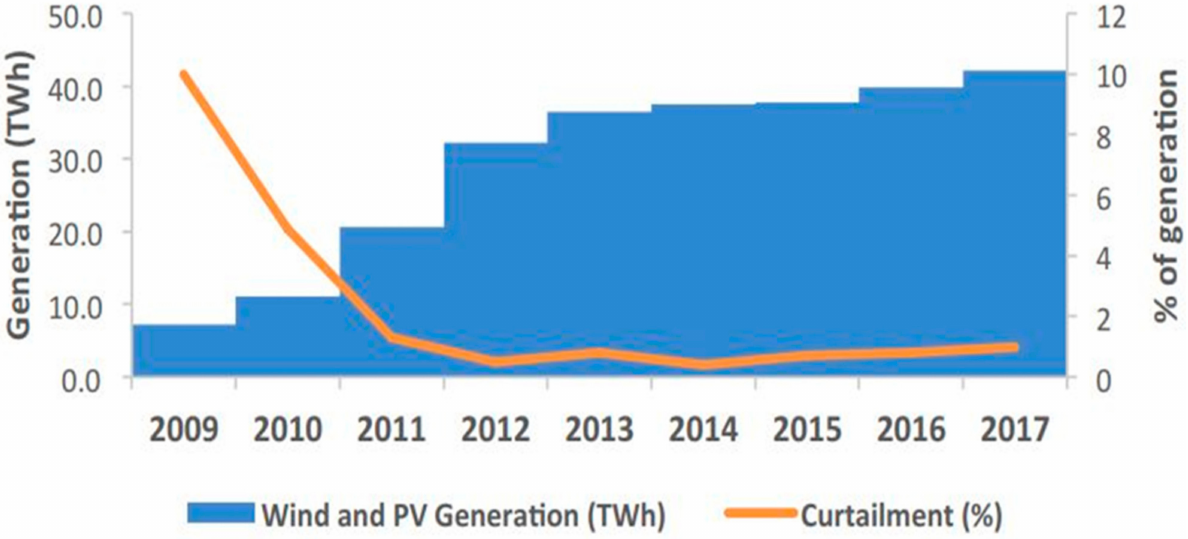
Figure 16. Wind/solar electricity generation and curtailment in Italy